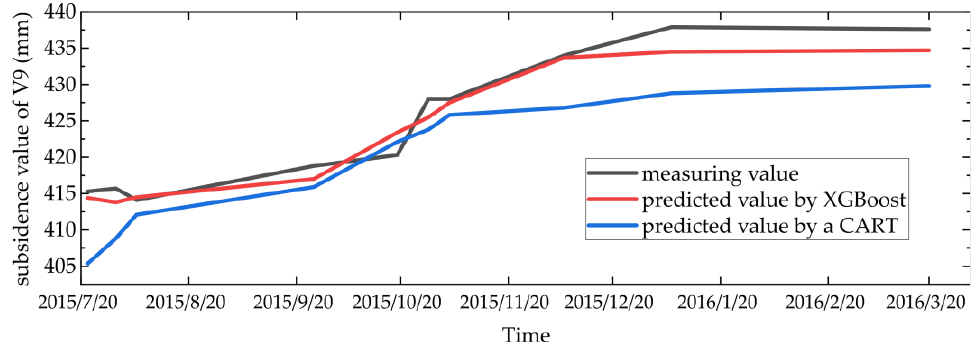
Figure 4. Predicted values and monitoring values of monitoring point V9 using different algo-